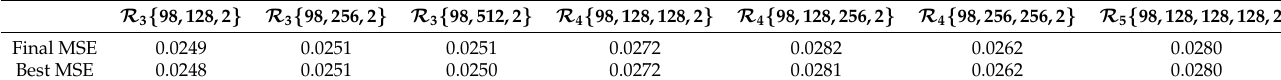
Table 4. Obtained final and best MSE values for different architectures of CERT.